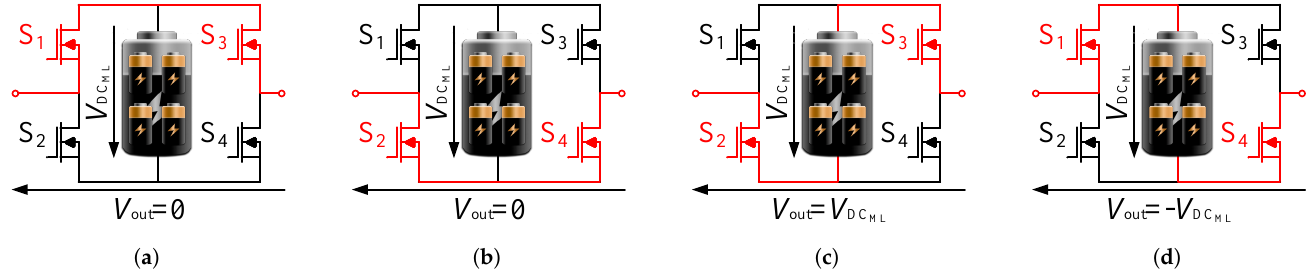
Figure 2. Valid switching combinations of each individual H-bridge converter. In ( a , b ) the battery module is bypassed. In ( c , d ) the battery module is inserted in forward and reverse direction, respectively.